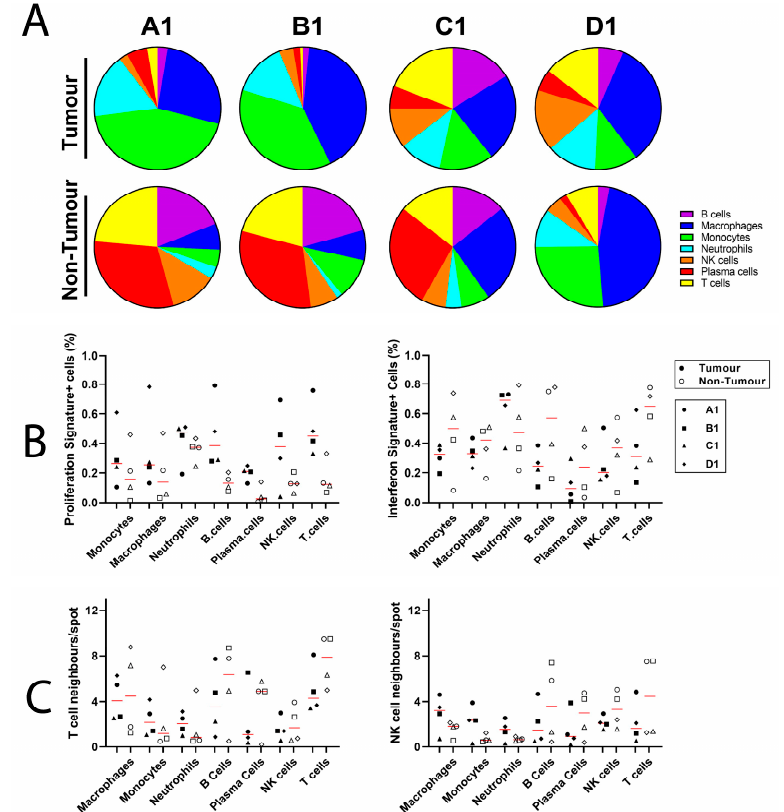
Figure 5. Analysis of BayesSpace -enhanced immune cell composition. ( A ) Imsig -characterised immune cell composition of BayesSpace enhanced tissue sections A1-D1 showing differences between tumour and adjacent non-tumour tissue. ( B ) Proportion of ImSig -characterised immune cell spots sharing proliferation and interferon signatures in tumour and adjacent non-tumour tissue. ( C ) Analysis of T- and NK-cell neighbouring spots among different immune cell populations in tumour and adjacent non-tumour